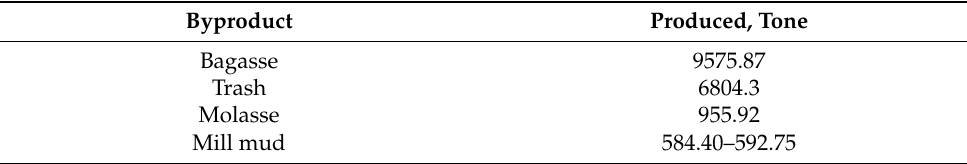
Table 36. Estimated global production of sugarcane byproducts is